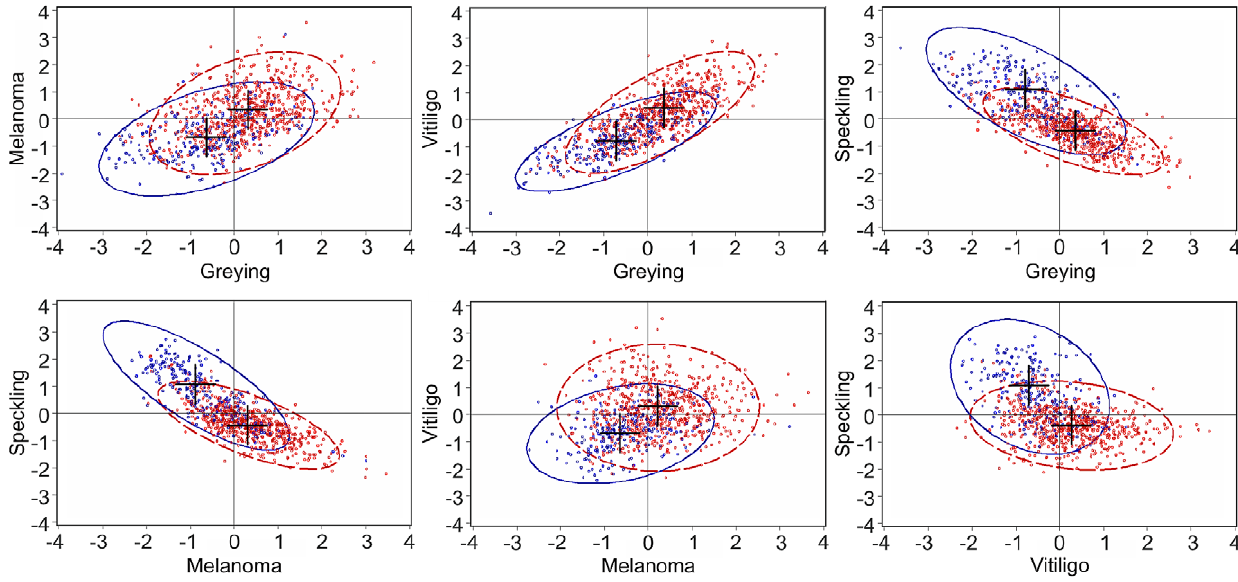
Figure 1. Scatter plots of standardized estimated breeding values (EBVs) from bivariate analysis (first scenario). EBVs were corrected for age and sex by stud by year effect. Homozygous ( GG ) animals are shown in red; heterozygous ( Gg ) animals, in blue. Contour plot ellipses contain 95% of the data.